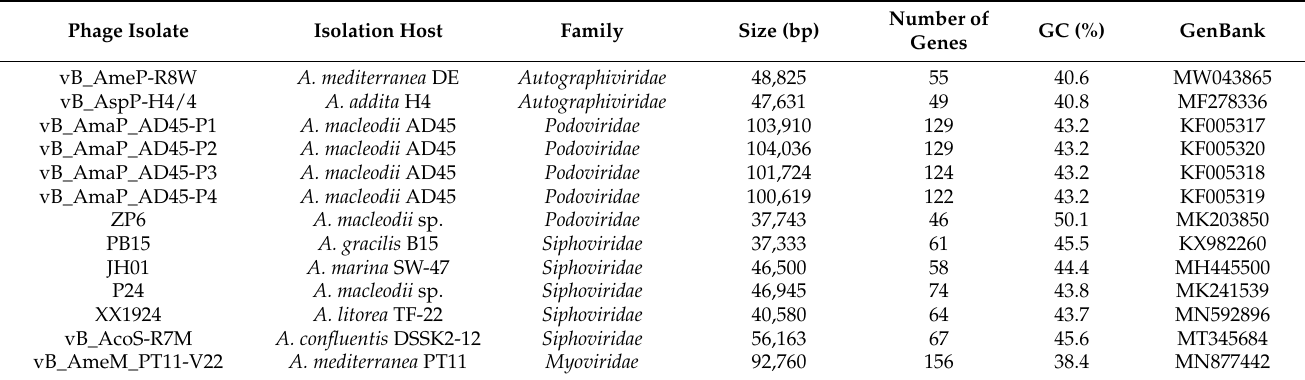
Table 1. Statistics of reported genomic information of